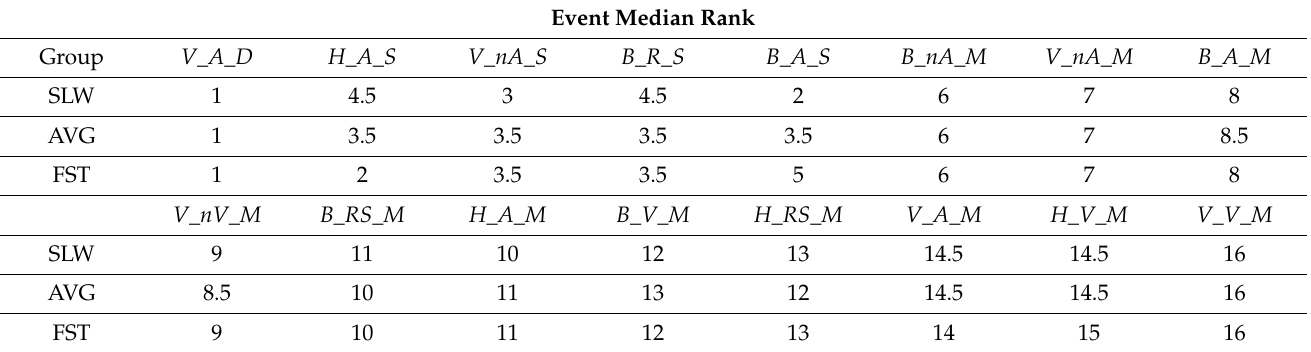
Table 3. The median rank of all measured events in the reverse punch timeline in relation to the examined sub-samples. Event Median